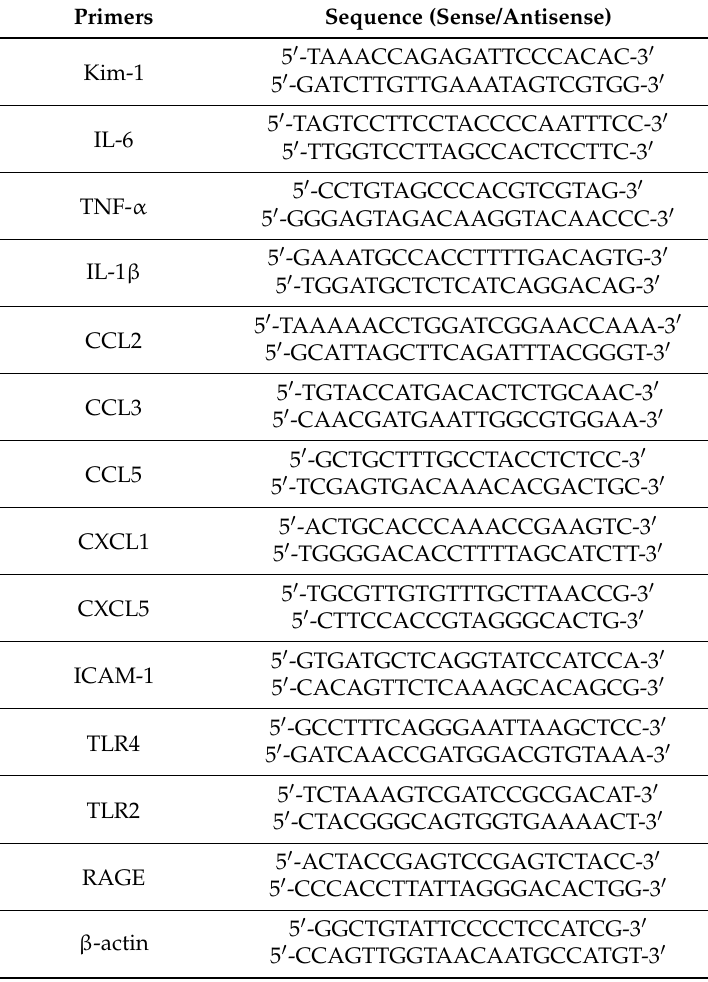
Table 1. Primers used to amplify cDNAs for